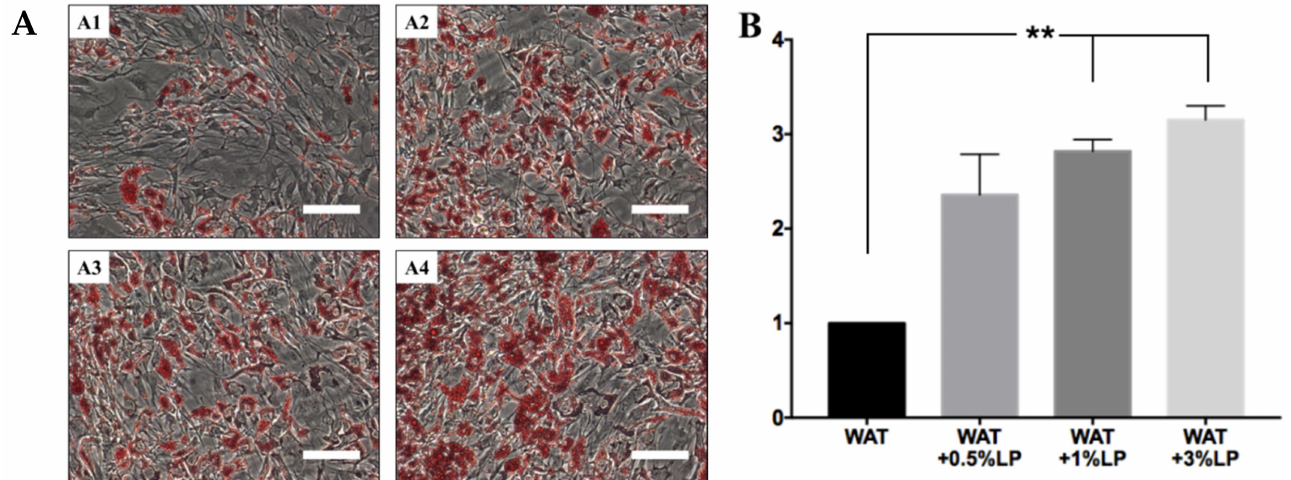
Figure 12. Oil Red O staining and quantification to evaluate the effect of hPL on adipogenic differentiation. hASCs after 10 days of adipogenic induction with or without hPL supplement (0.5%, 1%, 3%). ( A ) Representative phase-contrast microphotographs illustrating triglycerides accumulation: ( A1 ) US-WAT only, ( A2 ) US-WAT + 0.5% hPL, ( A3 ) US-WAT + 1% hPL, and ( A4 ) US-WAT + 3% hPL. Fold magnification 100 × . Scale bar 100 µ m. ( B ) Quantification of Oil Red O staining. 100% 2-propanol was used as background control and subtracted to the four test samples’ measured optical densities (ODs), which were then normalized on the number of nuclei present on every dish. The data refer to the value obtained with cells grown with US-WAT only, thus this bar chart shows the fold variation of absorbance related to this sample. The results represent the average ± SD of three different samples. Statistical analyses were performed as one-way ANOVA using Prism7 software, ** p <